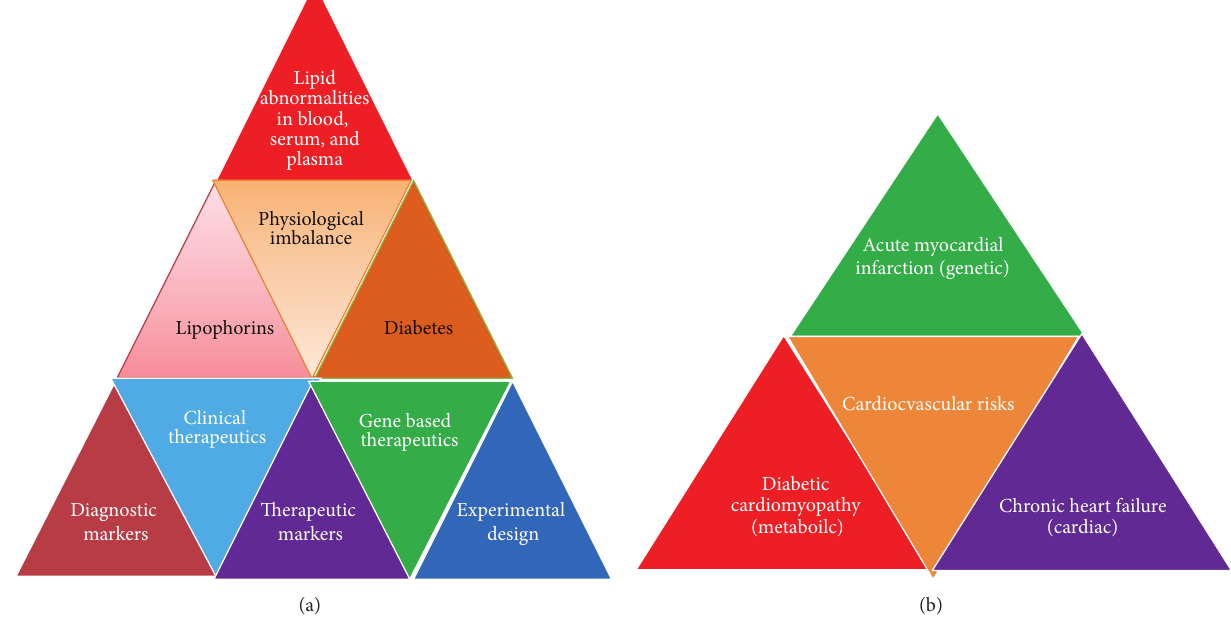
Figure 3: (a) and (b) showing interrelationship of lipid abnormalities and associating risk factors with diagnostic and therapeutic measures.